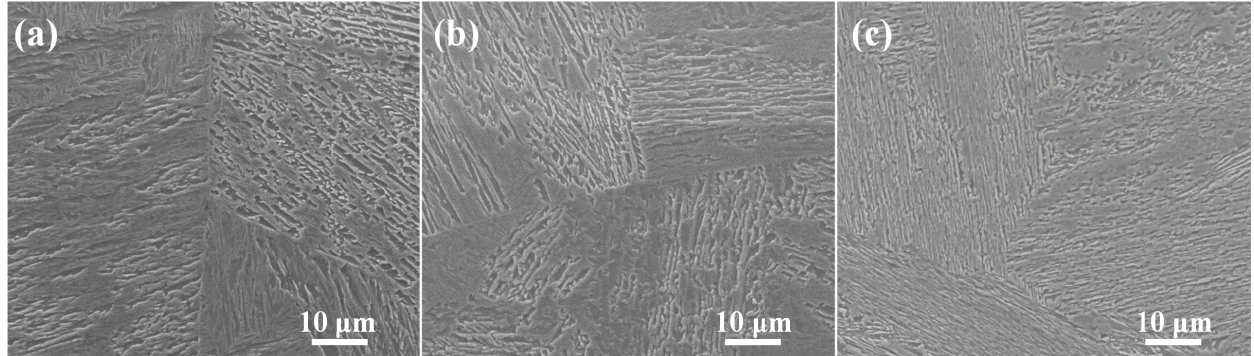
Figure 1. SEM micrographs of ( a ) IT698, ( b ) IT673 and ( c ) IT623.